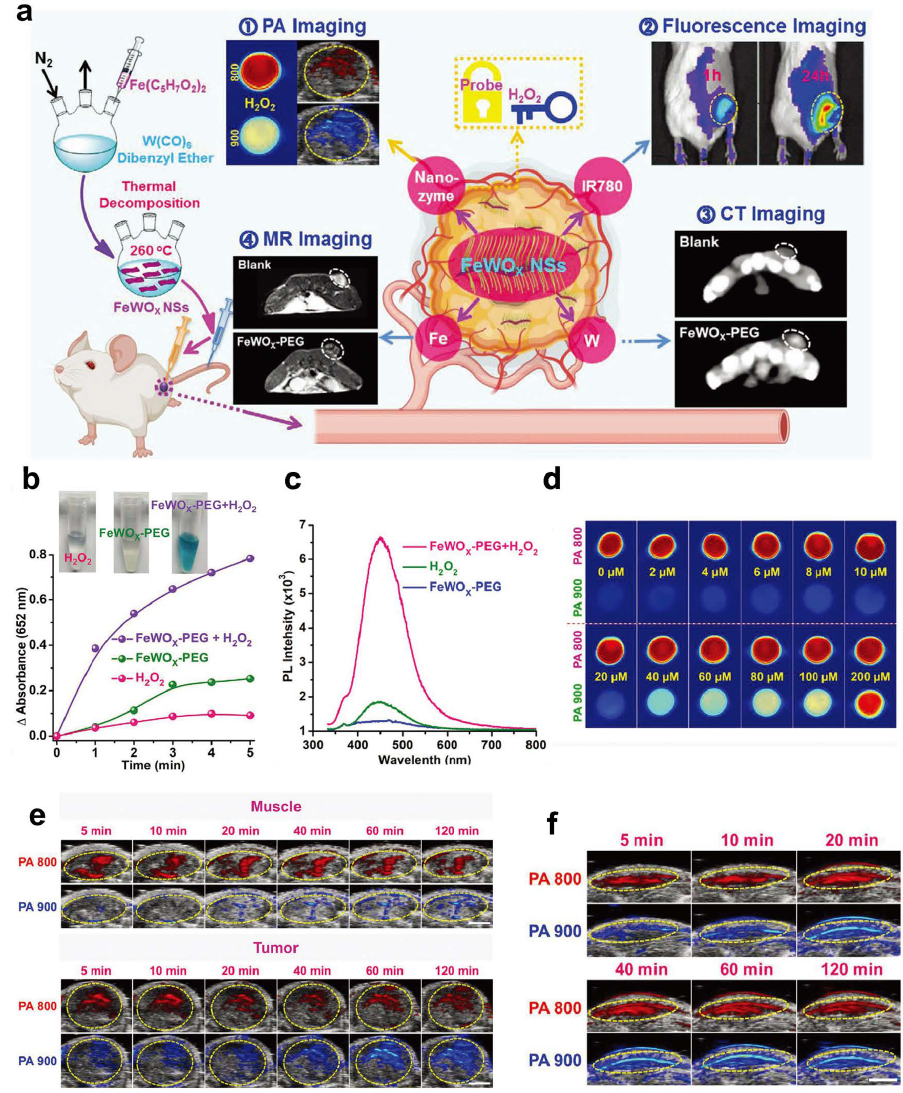
Figure 8. FeTIR for multimodal imaging. ( a ) Schematic illustration showing the preparation of oxygen-deficient bimetallic oxide FeWOX nanosheets as peroxidase-like nanozymes for sensing tumors via multimodal imaging. ( b ) Comparison of TMB oxidation by FeWOX-PEG, H 2 O 2 , and FeWOX-PEG/H 2 O 2 . ( c ) Fluorescence spectra obtained from different treatment groups containing H 2 O 2 , FeWOX-PEG, and FeWOX-PEG/H 2 O 2 . ( d ) In vitro ratiometric PA imaging at different concentrations of H 2 O 2 (0–200 × 10 − 6 M) with the FeTIR nanoprobe. ( e ) In vivo ratiometric PA imaging of muscle and 4T1 tumor tissues of mice after injection of the FeTIR nanoprobe. ( f ). In vivo ratiometric PA imaging of inflammation sites in mice after FeTIR nanoprobe injection. Reproduced with permission from Ref. [115]. Copyright © 2020 Wiley-VCH GmbH.